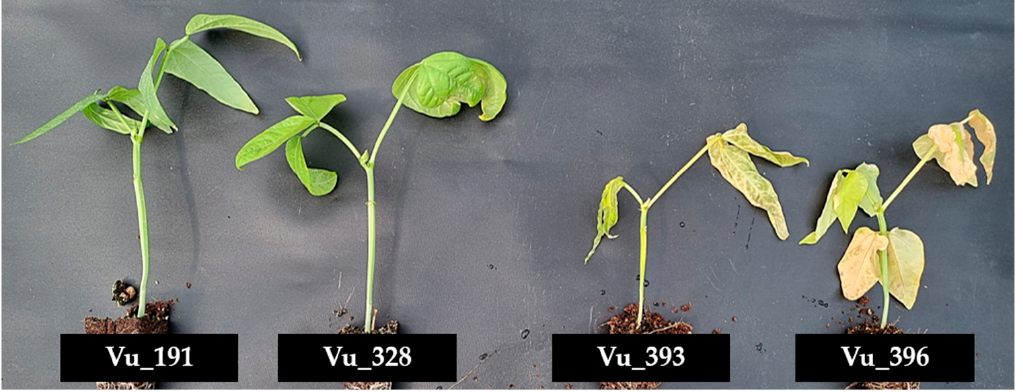
Figure 1. Four cowpea germplasms with different levels of salt tolerance exposed to a 250 mM NaCl solution for three weeks.